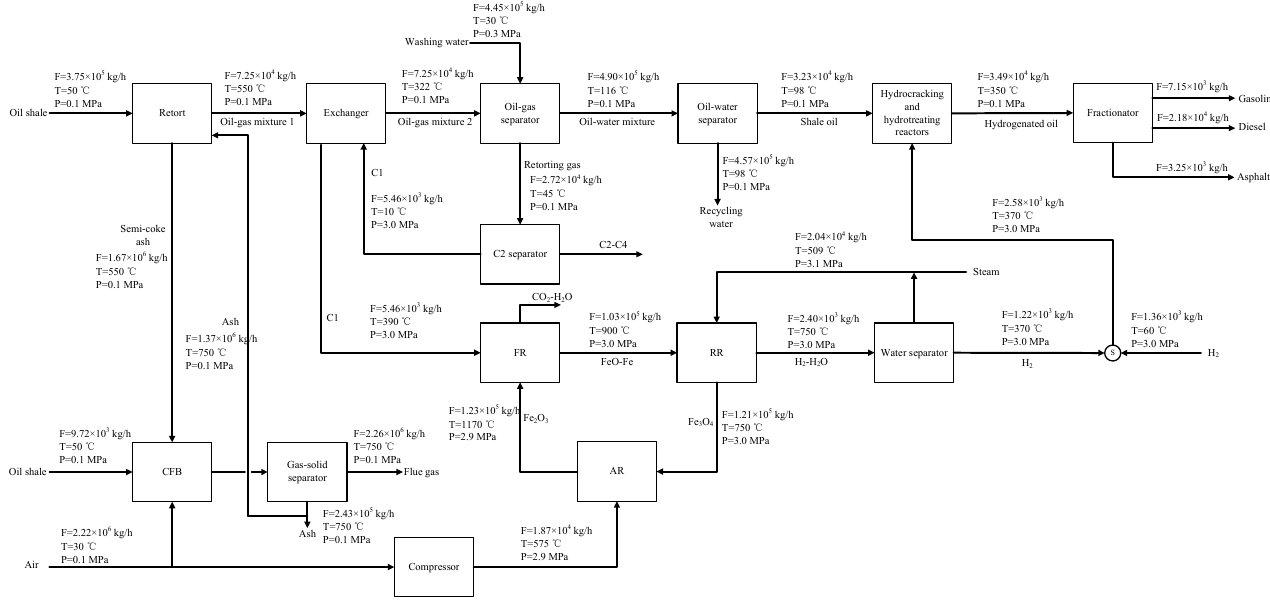
Figure 13. Material flow of the CLeSTL process (oil full fraction hydrogenation).